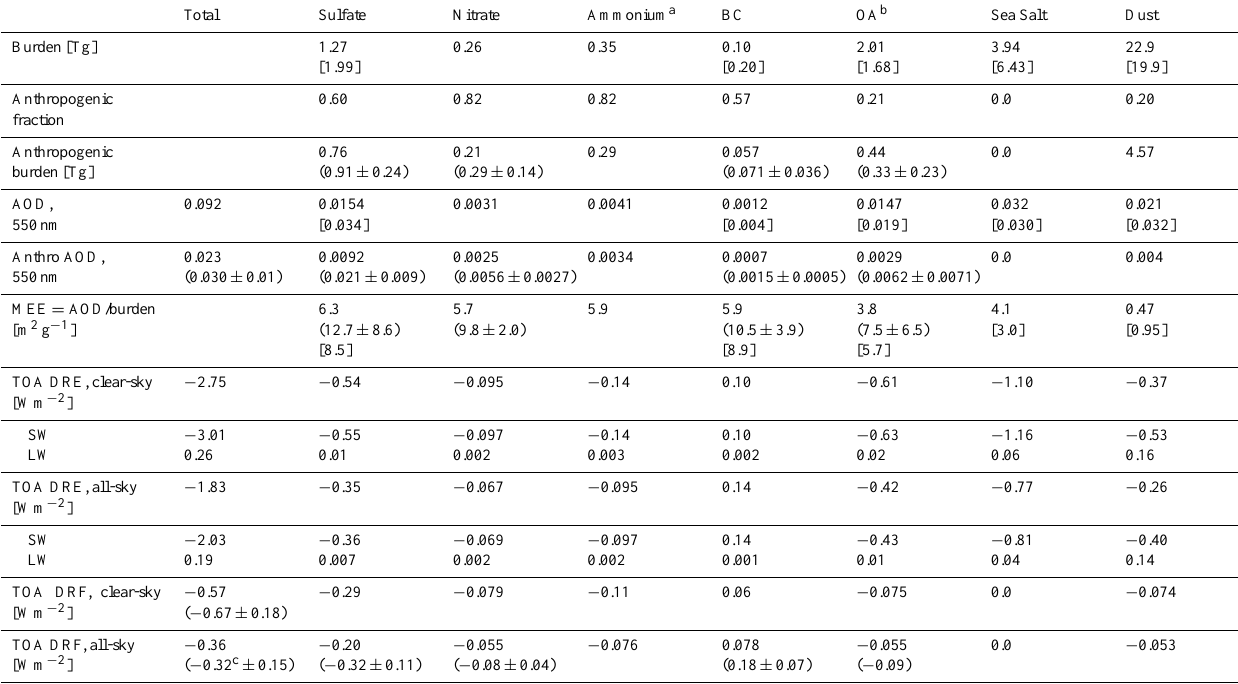
Table 3. Global annual mean aerosol budget and impacts simulated for 2010 using GC–RT (comparisons with AEROCOM II means from Myhre et al. (2013) in round brackets; comparisons with AEROCOM I medians from Kinne et al. (2006) in square brackets). Note anthro- pogenic here does not include biomass